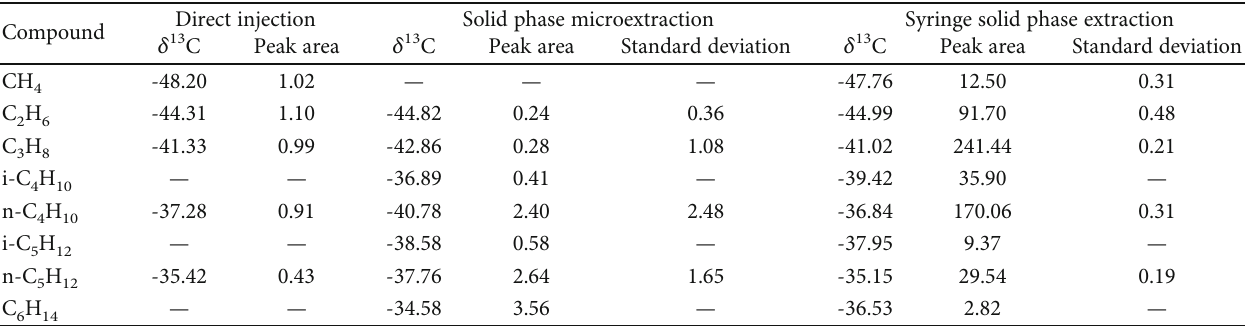
Table 5: δ 13 C ratios ( ‰ ), S (mV), and SD ( ‰ ) obtained from DI, SPME, and SSPE.